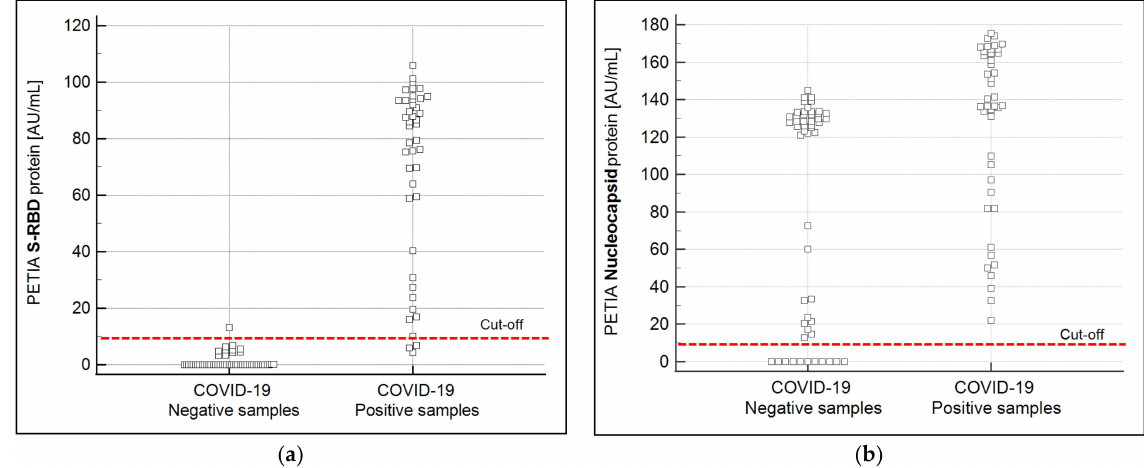
Figure 3. Graphical representation of the sample recovery of the S-RBD ( a ) and the N ( b ) protein- based PETIA. The overlapping of the negative and the positive samples for the N-based PETIA is consistent with the theoretical assumptions of the bioinformatical finding that N protein-based immunoassays reveal more unspecific cross-reactivity. The dashed red line indicates the cut-off of the used PETIA